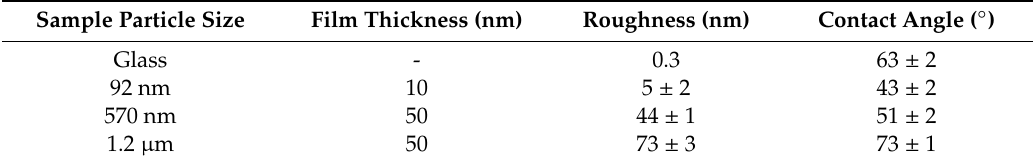
Table 1. Roughness and contact angle measurements of di ff erent Ag particle samples.